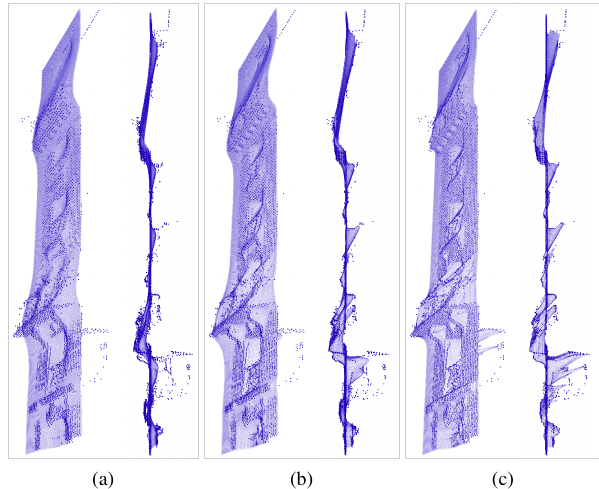
Figure 14: Three parameterizations for the same facade piece (three-quarters and profile view). From left to right, the data term increases and the smoothness term decreases. The surface be- comes less simple and more rugged, but closer to the lidar